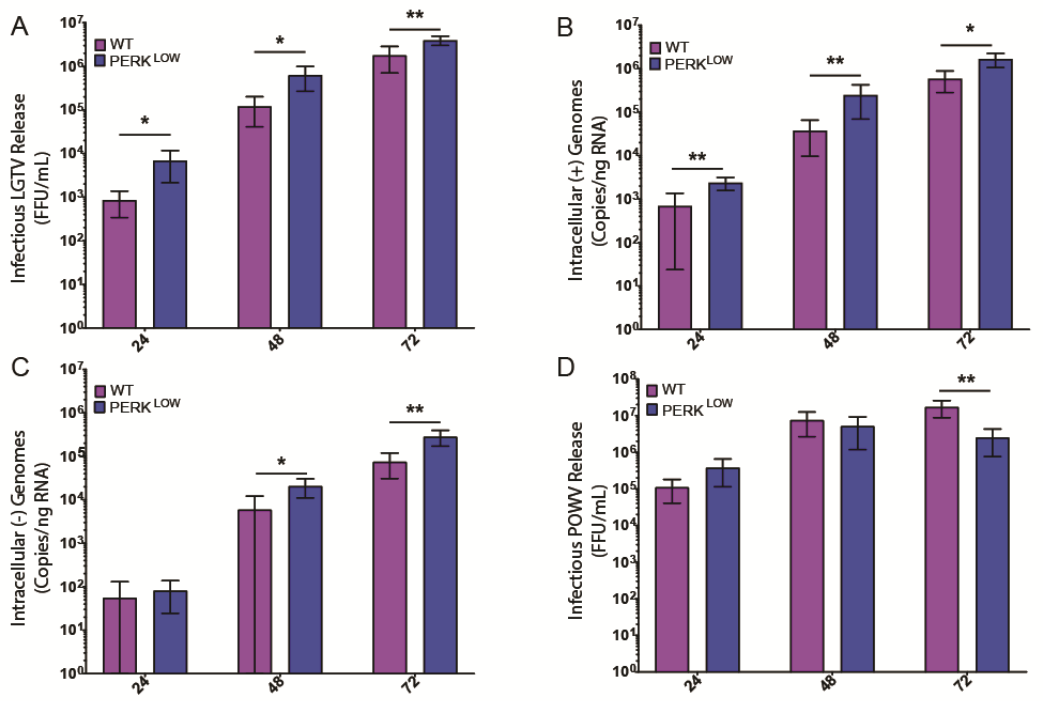
Figure 3. PERK has an antiviral e ff ect on infectious LGTV release and genome replication. ( A ) PERK LOW HEK293T cells released higher infectious titers at all examined timepoints compared to WT HEK293T cells following infection at MOI = 1. ( B ) PERK LOW HEK293T cells produced higher quantities of ( + ) sense genomic LGTV RNA at all examined time points compared to WT HEK293T cells following LGTV infection at MOI = 1. ( C ) PERK LOW HEK 293T cells contained higher quantities of (-) sense genomic LGTV RNA at 48 and 72 hpi compared to WT HEK293T cells following LGTV infection at MOI = 1. No di ff erence was observed at 24 hpi. ( D ) PERK LOW HEK293T cells had no significant di ff